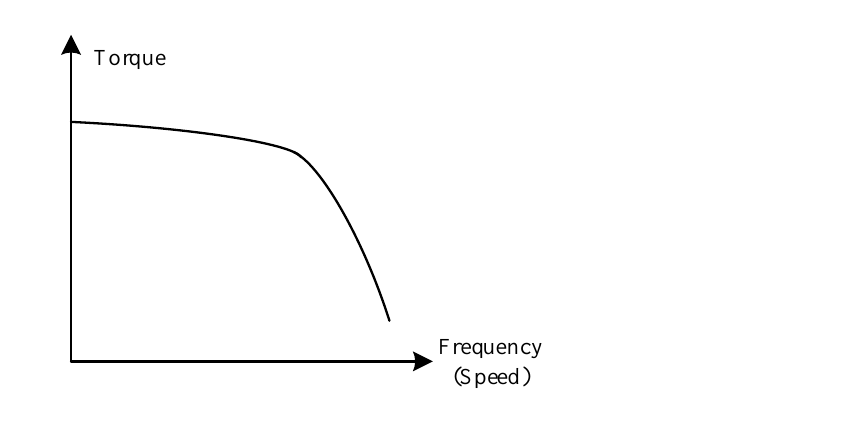
Figure 3. Torque-frequency(speed) characteristics of the HSM.